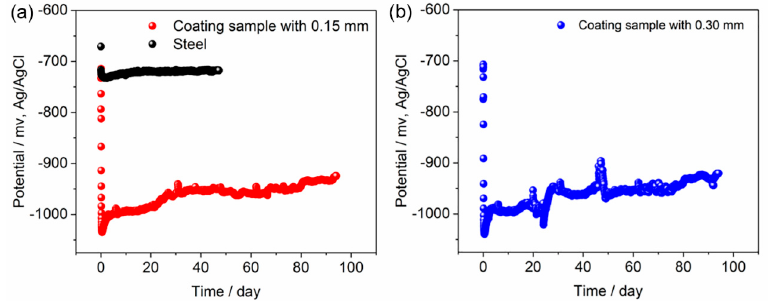
Figure 5. Open circuit potential of coatings tested in 0.5 wt% NaCl and 3.5 wt% (NH 4 ) 2 SO 4 for